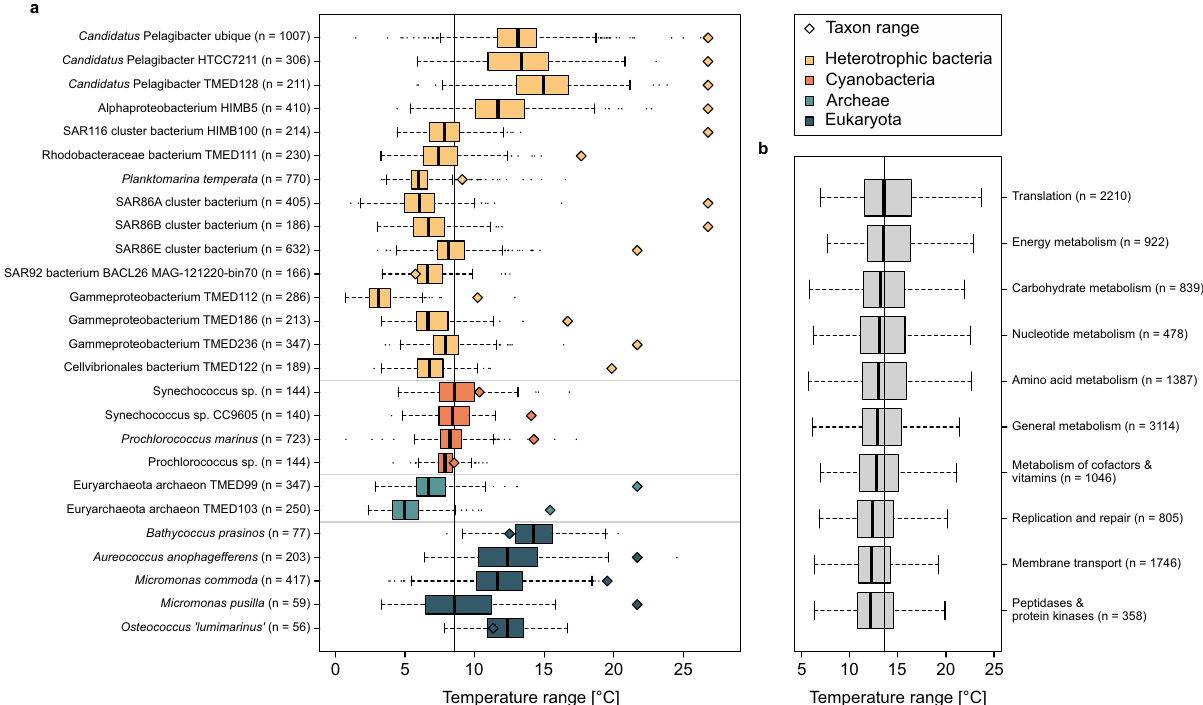
Fig. 6 Mean temperature range of gene variants of highly abundant taxa and functional gene categories of the AOM. a Box – Whisker plots of the mean temperature range of the abundance of single gene variants of all KOs in various abundant taxa of the AOM. The diamond indicates the temperature range of the taxon as a reference. b Box – Whisker plots of the mean temperature range of the abundance of gene variants of the listed KEGG BRITE. Vertical lines in each plot indicate the mean temperature range of all genes of the AOM. Numbers in brackets indicate the number of genes included in the analysis. Median values are represented by vertical lines, interquartile ranges shown as boxes, whiskers extending up to 1.5 times the interquartile range, and points showing